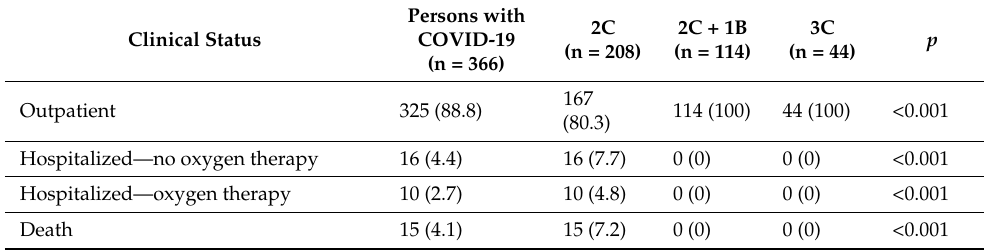
Table 2. Clinical status of patients with COVID-19 by vaccination status.